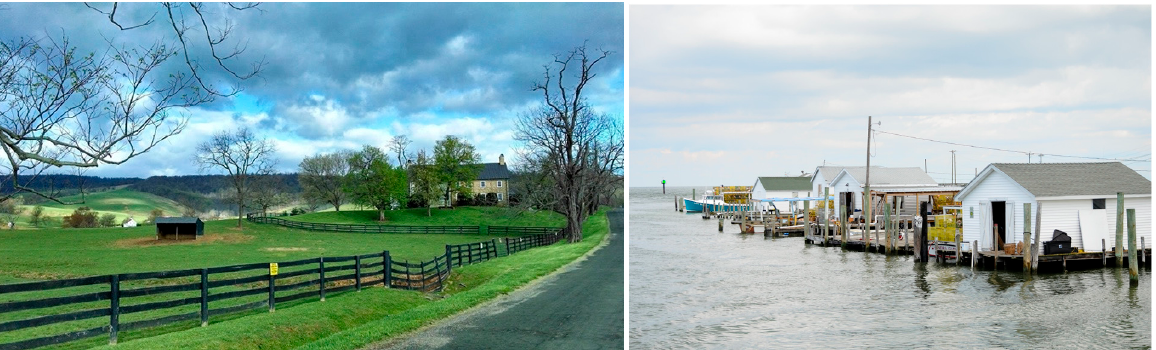
Figure 7. Cultural content conveys a deep meaning of human activity. The fences, pastures, and animal sheds in the image on the left convey deep meaning about the agricultural activity The fact that it appears well maintained conveys a feeling of cultivation and care of the land and animals. (Titled “April in Paris” by Janet White, courtesy of Scenic Virginia—photo has been altered.) The fishing huts, boats, and crab traps in the image on the right convey the deep meaning of fishermen and their boats going out to sea and bringing back crabs. (Titled “Huts in Tangier Island” by Arun Kumar, courtesy of Scenic Virginia.)